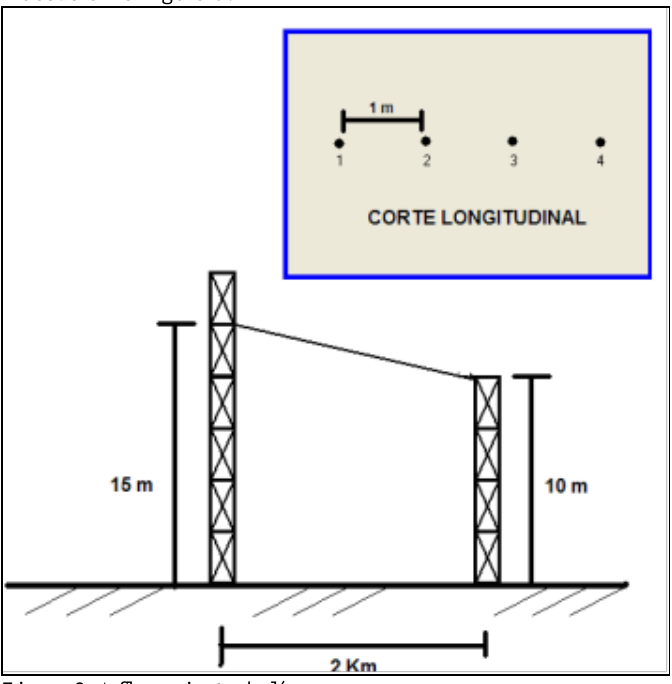
Figura 6: Afloramiento de línea. Fuente: Los Autores,